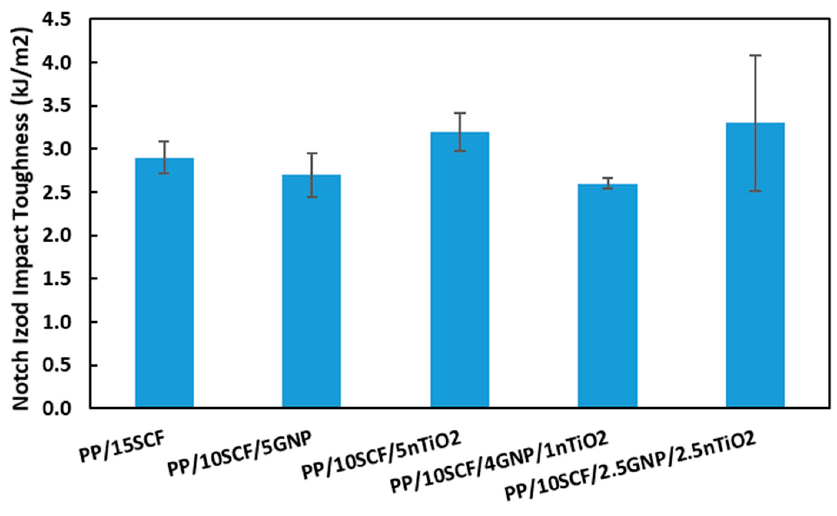
Figure 17. Notch Izod impact toughness at 15 wt % loadings for different composites.